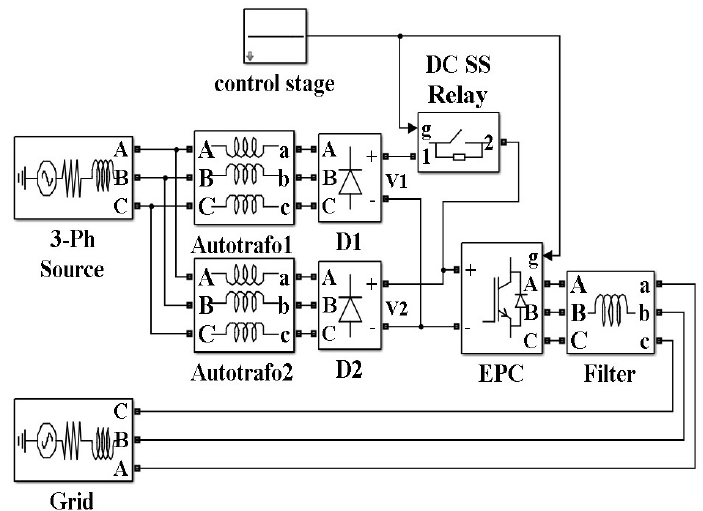
Figure 6. Connection diagram to generate a step in the input voltage V in